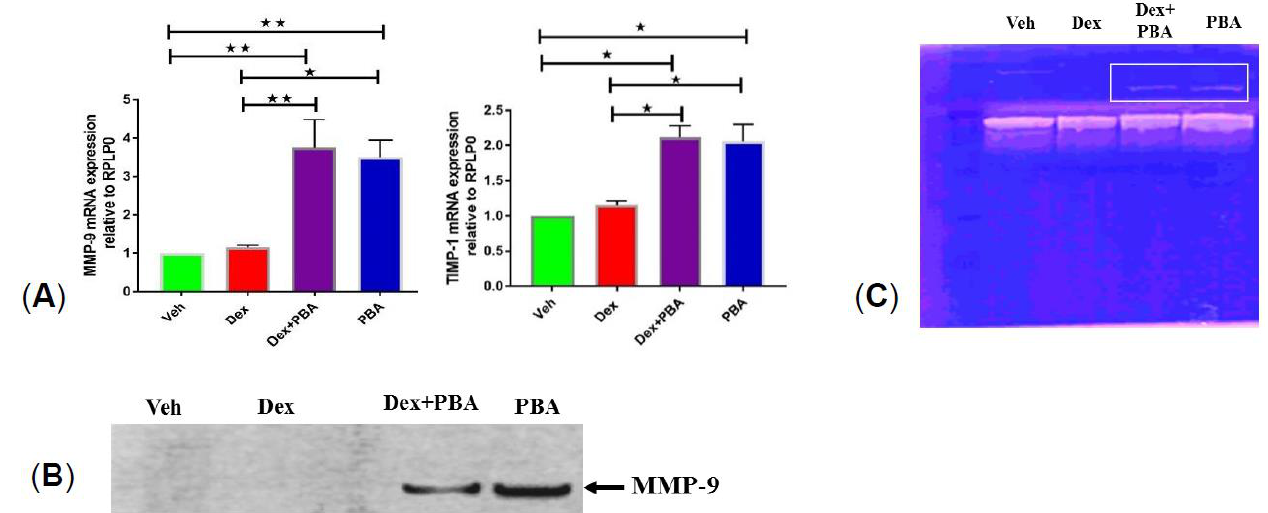
Figure 6. PBA induced MMP9 expression and activity: A ) relative mRNA expression level of MMP9 and TIMP-1 in transformed human GTM-3 cells, treated with either ethanol (Veh) or Dex (100 nM) or Dex + PBA (5 mM) or PBA for 24 h. Conditioned media was subjected to Western blotting ( B ) and gelatin zymography ( C ). We observed a prominent increase in protein expression ( B ) and the enzymatic activity ( C ) of MMP9 (represented by white box) in the conditioned media derived from Dex + PBA and PBA treated TM cells, but not in ethanol and Dex treated GTM-3 cells. ( n = 3, ONE WAY ANOVA with multiple comparison, ★ indicates p < 0.05, ★★ indicates p < 0.001).